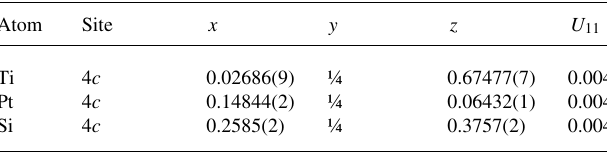
Table 6. Atomic coordinates and displacement parameters (in Å 2 )